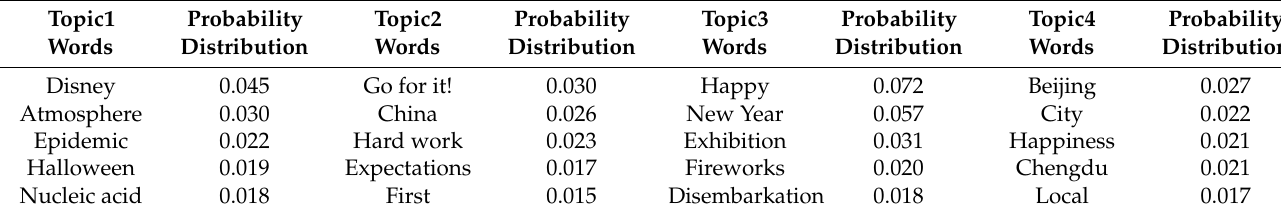
Table 16. B4 LDA theme model results.